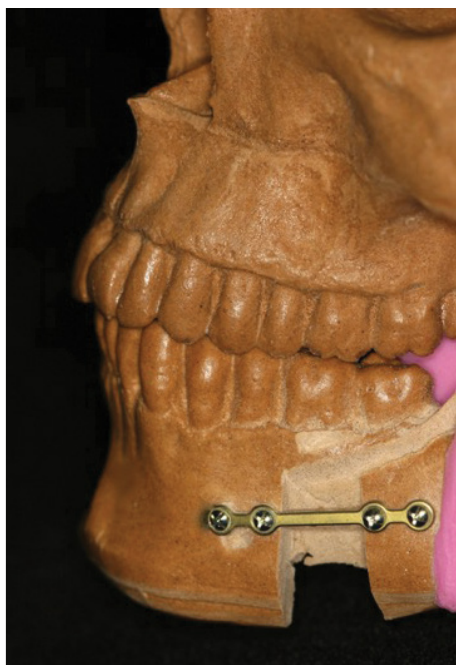
Figure 3. Lateral view of artificial skull after 10mm mandibular